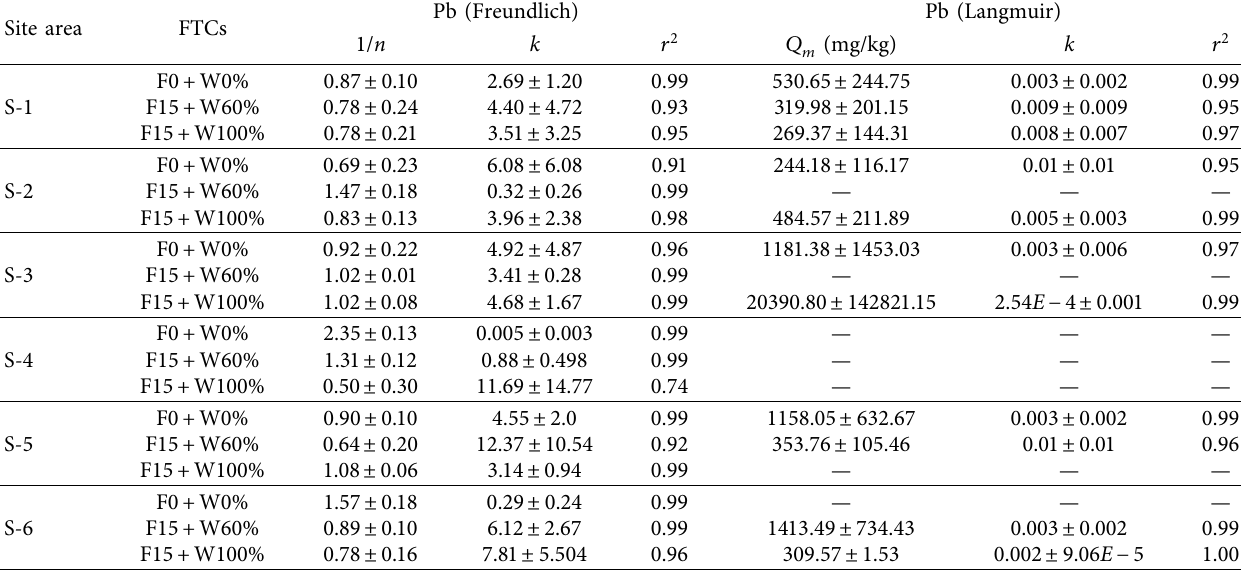
Table 1: Freundlich and Langmuir parameters of Pb in soils under different freeze-thaw conditions. Pb Site area FTCs